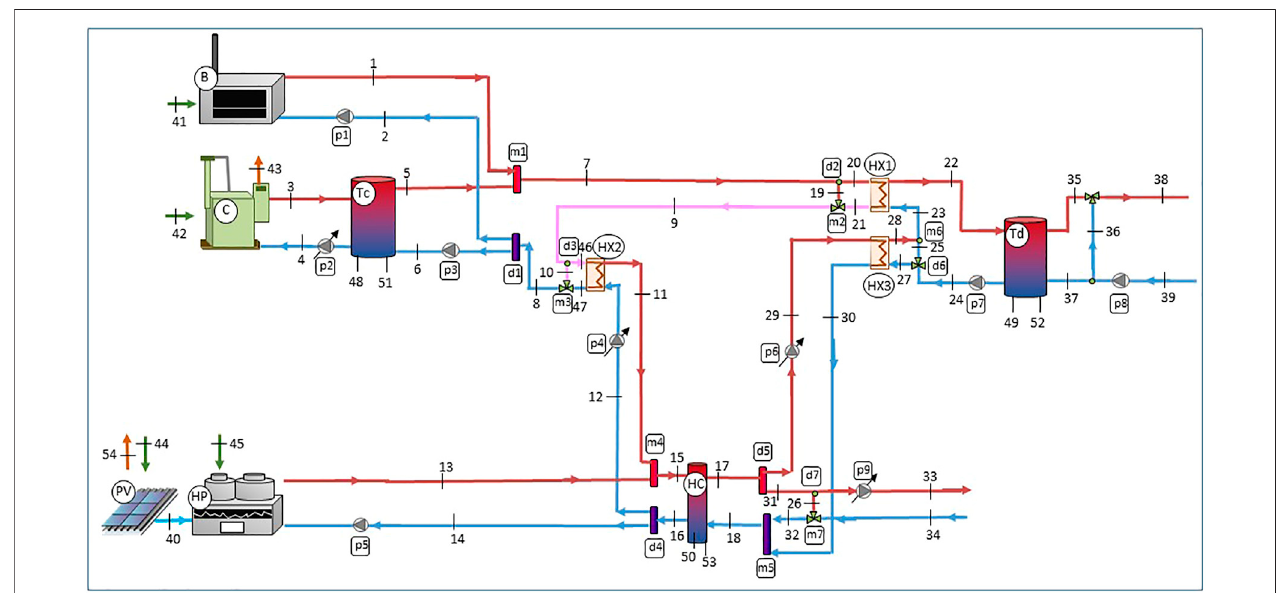
FIGURE 5 | Physical model of the system with numbered fl ows and